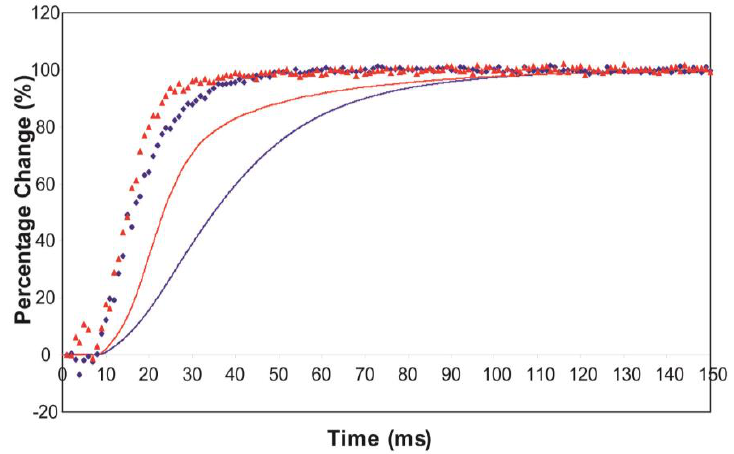
Figure 5. Plots of the A(10) to A(11) intensity ratio (intensity of (10)/intensity of (11), written as I(10)/I(11)) and tension during the rising phase of tetanic contraction in Plaice fin muscle for both datasets under the two different SL conditions (without control in blue, with partial SL control in red, tension solid lines, intensity ratio discrete points). For comparison the time-courses have been normalised (as in Figure 8) with respect to their average values over 100 ms in the relaxed state (0%) and 100 ms at the plateau of contraction (100%) to show the percentage of maximum change. There is a very clear lead of intensity changes ahead of tension.